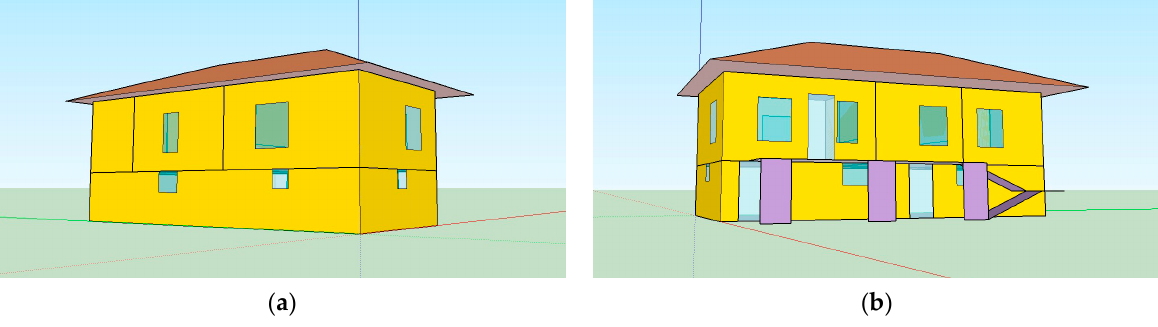
Figure 6. SketchUp model for the energy performance simulation: ( a ) street view, ( b ) courtyard view.